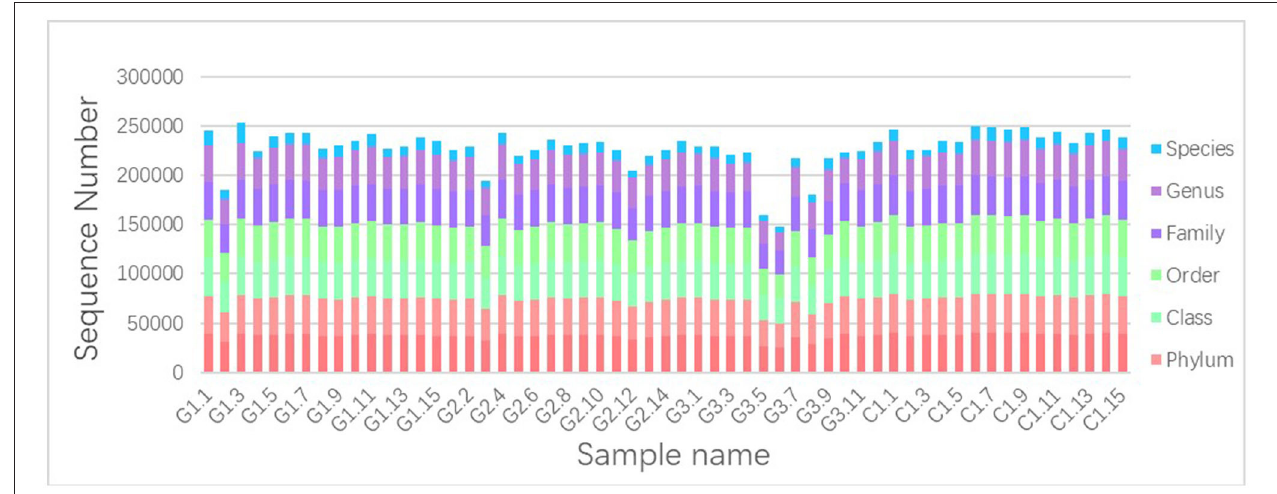
FIGURE 1 | Number of gene sequences in each sample. The abscissa is the sample name; the ordinate indicates the number of sequences that are annotated to that level; the top-down color order of the histogram corresponds to the legend’s color order on the right.